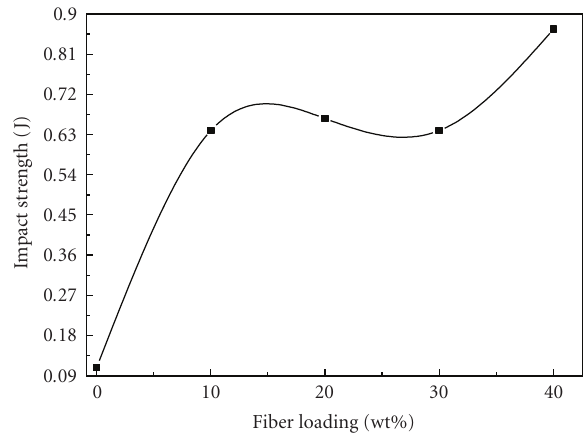
Figure 6: E ff ect of fiber loading on impact strength of composites.